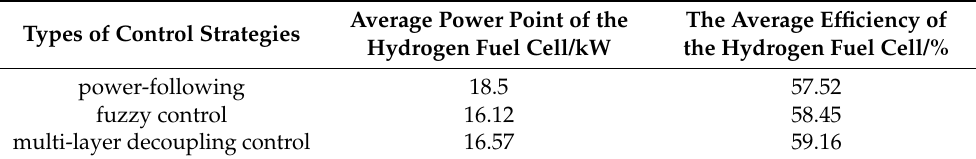
Table 3. Comparison of the fluctuation of the PEMFC of different control strategies.